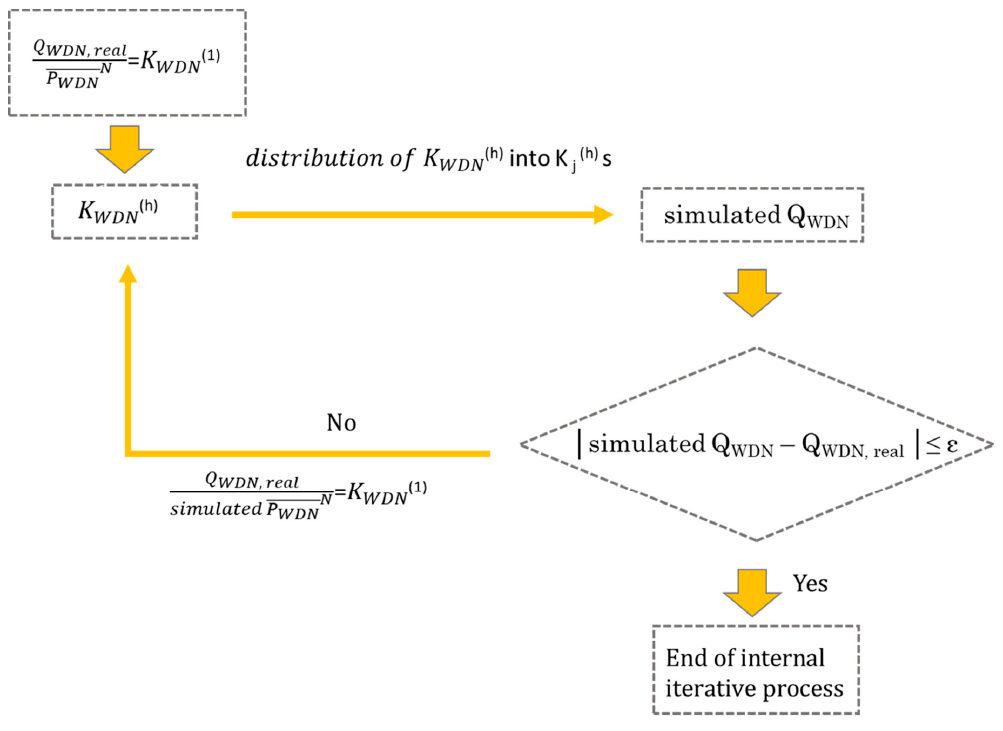
Figure 11. Scheme for the inner loop of the methodology as adapted from the corresponding Cobacho, et al. [18] loop.